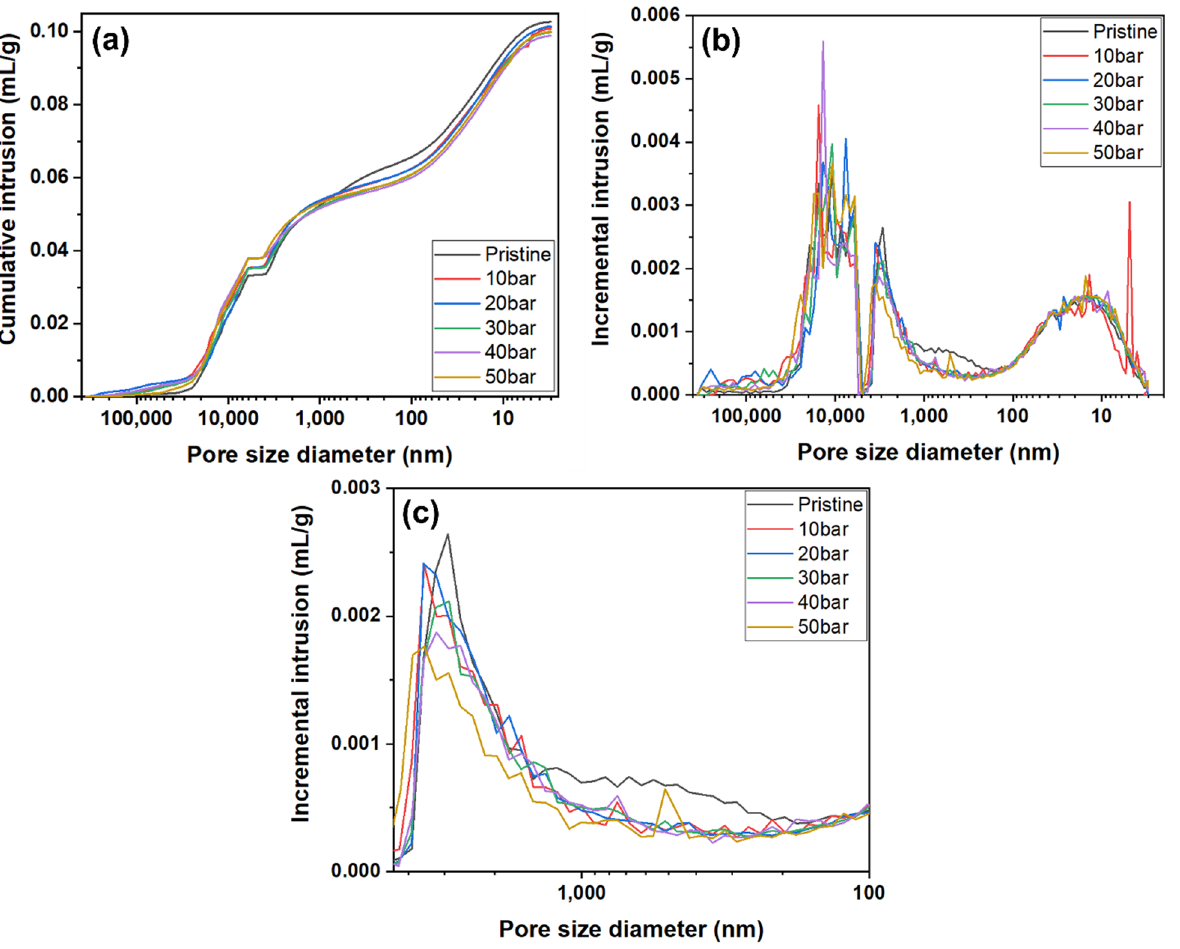
Figure 6. Mercury intrusion porosimetry curves of graphite blocks before and after impregnation at various pressures: ( a ) cumulative intrusion, ( b ) incremental intrusion in range of pore size diameter 360,000 nm to 3 nm, and ( c ) expansion of the incremental intrusion in range of pore size diameter 4500 nm to 100 nm.